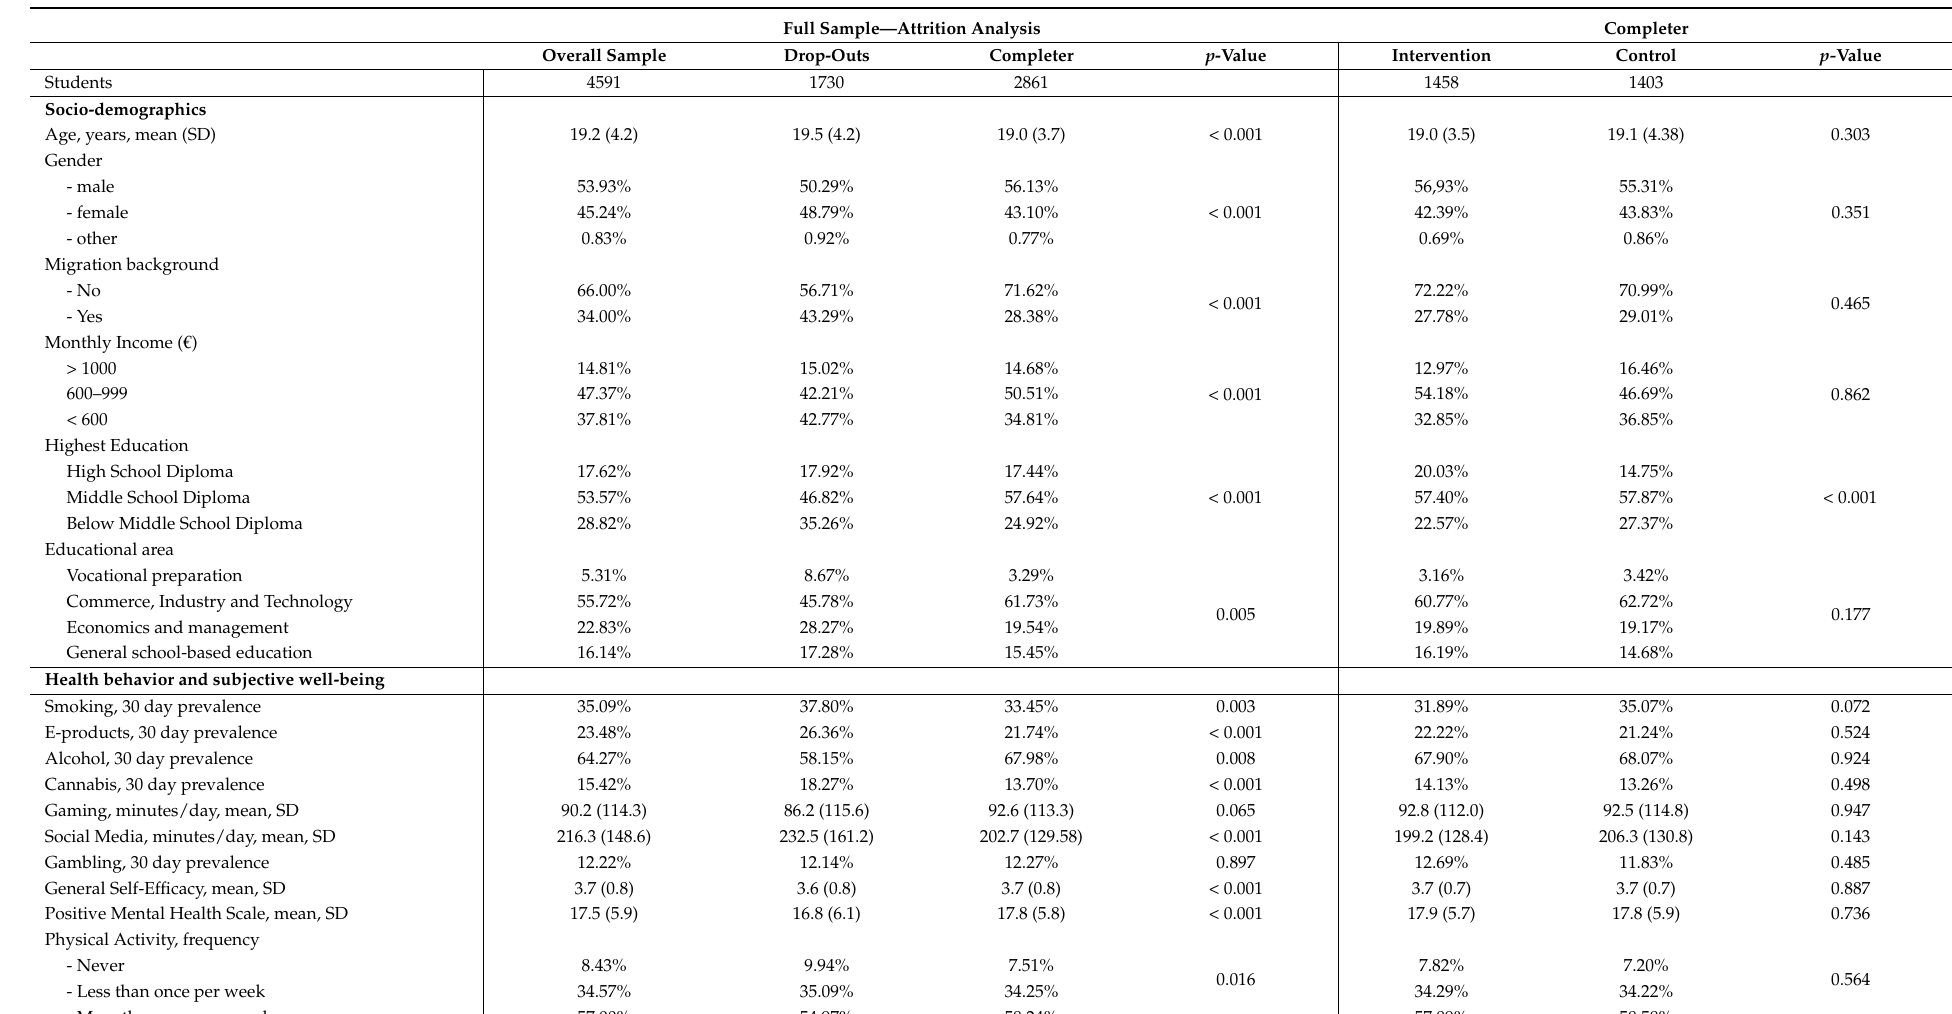
Table 1. Baseline statistics, attrition analysis, and differences between the intervention and control